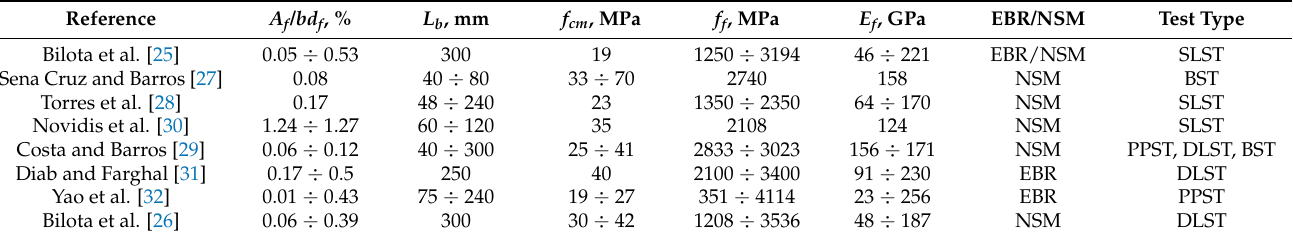
Table 2. Main parameters of pull-off/out shear tests.